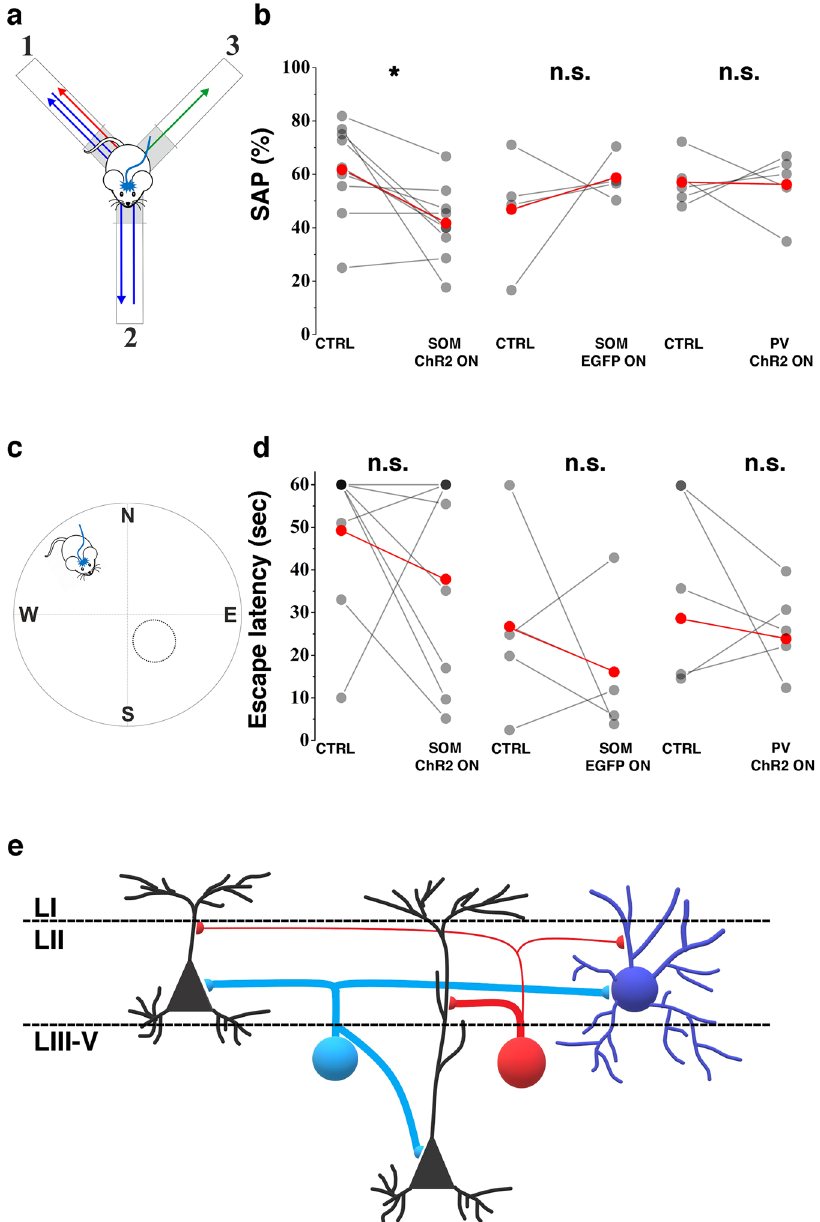
Fig. 6 The inhibition of deep layer cells by SOM + GABAergic interneurons regulates short-term memory formation without in fl uencing spatial navigation. a Schematic indicating the design of the Y-maze experiment combined with optogenetic stimulation of SOM + cells in the MEC. Light was illuminated into the MEC during exploration, when animal was in the center area (gray). Alternation was considered correct, when after two entries (e.g., arms #1, #2) the animal entered the unvisited (#3) arm. b Correct spontaneous alternations of ChR2-expressing SOM-Cre (left), EGFP-expressing SOM- Cre (middle), and ChR2-expressing PV-Cre animals (right) during control (CTRL) and during ChR2 exciting light (ON) (* p < 0.05, paired Student ’ s T test). c Schemati c representing the Morris water-maze experiments. Light pulses exciting ChR2 + SOM cells were applied while the animal was fi nding the hidden platform on the last day (day 6) of the trainings. d Escape latencies of ChR2-expressing SOM-Cre (left), EGFP-expressing SOM-Cre (middle), and ChR2- expressing PV-Cre animals (right) during control (CTRL) and during light pulses (ON). e Schematic summarizing the network motif revealed in the present study. Layer II pyramidal (black, left), layer II stellate (black, right), layer III – V pyramidal (black, bottom), PV + interneuron (PV, blue), and SOM + interneuron (SOM, red). Thicker axons represent stronger inhibition on the targeted